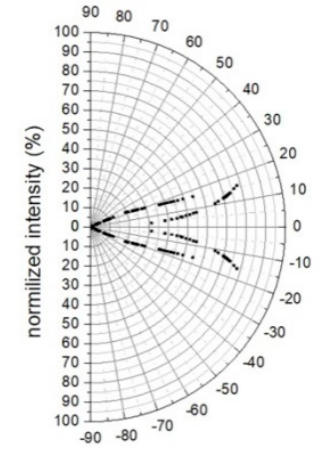
Figure 9. Ray optic modeling of angular intensity distribution of radiation modes exiting from the sides of the fiber taper ( α = 2°).